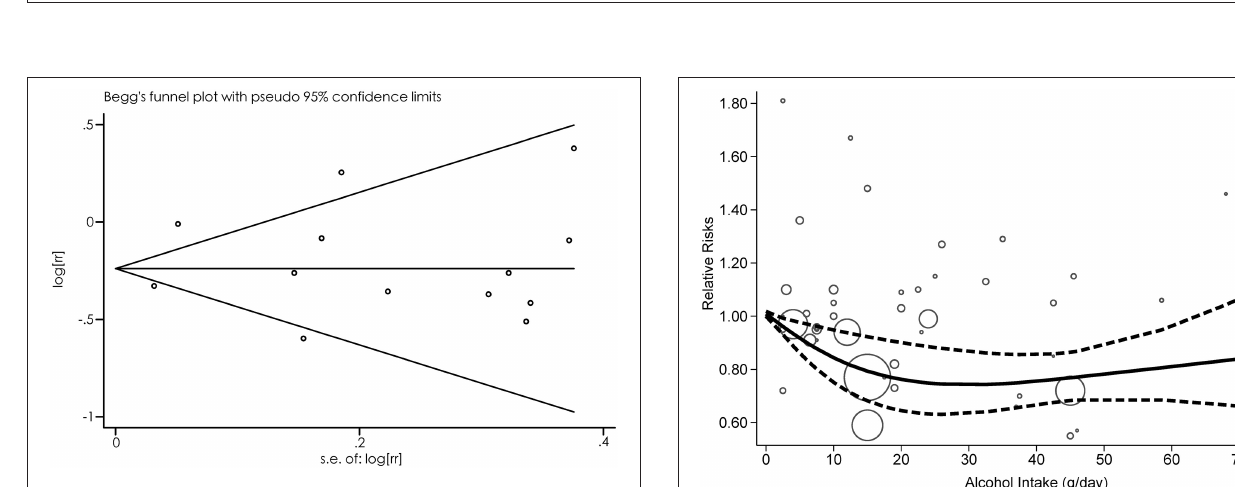
FIGURE 2 | Forest plots for the relationship between Parkinson’s disease (PD) risk and alcohol consumption.